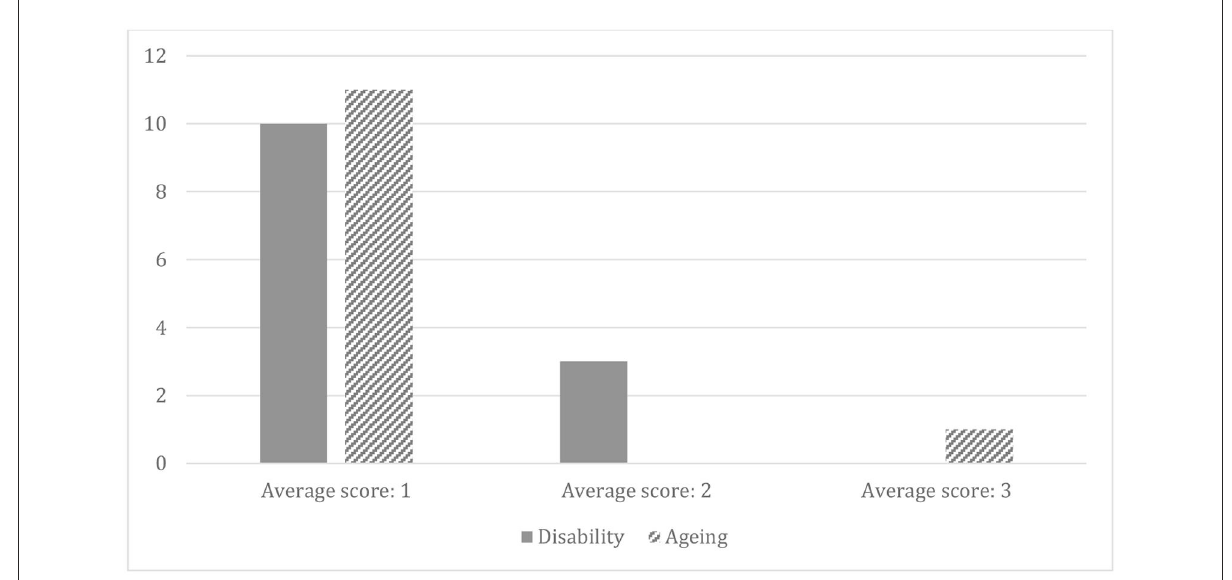
FIGURE1 The average score awarded to references to core concepts across disability and